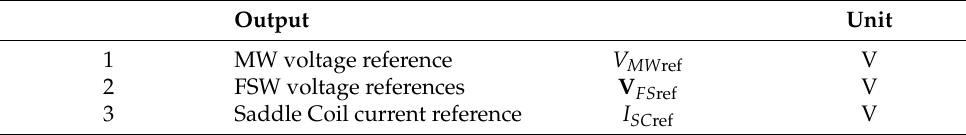
Table 2. List of the outputs of the axisymmetric